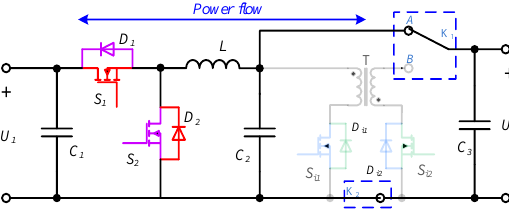
Figure 6. The equivalent circuits of the proposed converter in non-isolated operation.